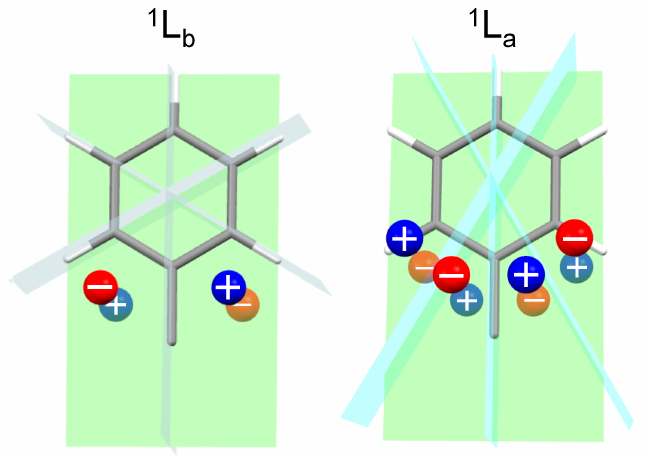
Figure 7. Sector rules for 1 L a and 1 L b ECD bands of monosubstituted benzene. The nodal planes (green: ring plane; light blue or cyan: perpendicular to ring plane) divide the space into sectors. A substituent, or a piece of a substituent, is viewed as a perturber placed in each sector and is represented by a sphere. Its contribution to the ECD band has the sign drawn on the spheres (blue, positive; red, negative). In the presence of further substituents on the ring (e.g., methyl groups attached at 2 ′ and 6 ′ ), the vertical nodal planes may be rotated around the vertical axis by an angle proportional to the substituent spectroscopic moment.